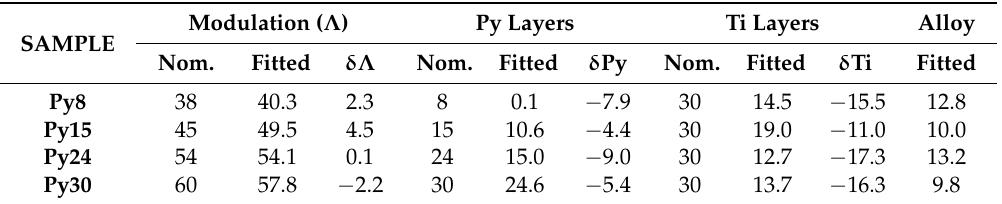
Table 1. Summary of relevant parameters of the X-ray reflectivity simulations for all the samples studied: nominal, fitted values, and difference between them ( δ ). All the quantities are in Å. SAMPLE